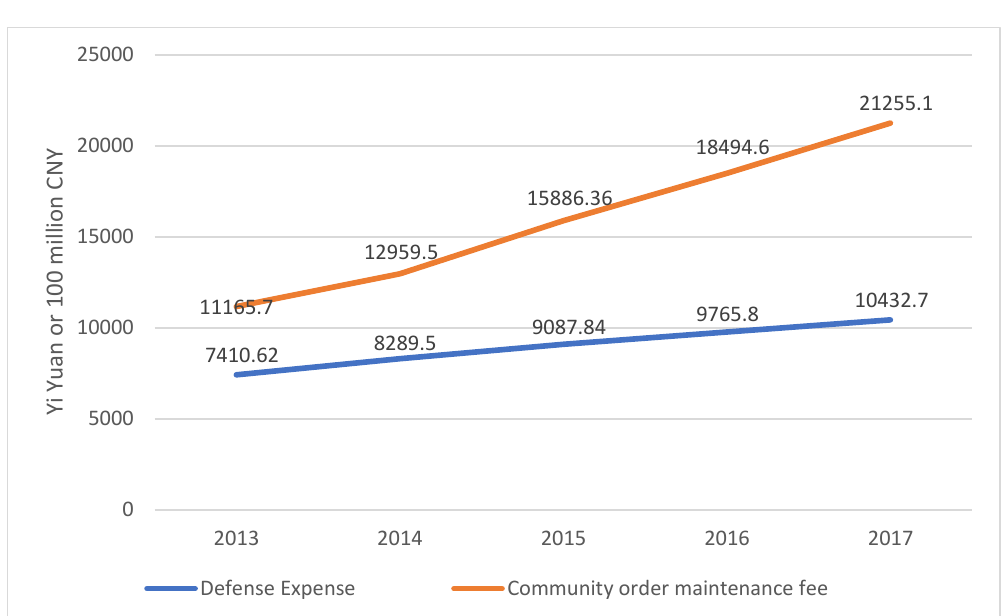
Fig. 3. The comparison of the Chinese government’s investment in community order maintenance and national defence (developed by the authors, based on National Bureau of Statistics of China,